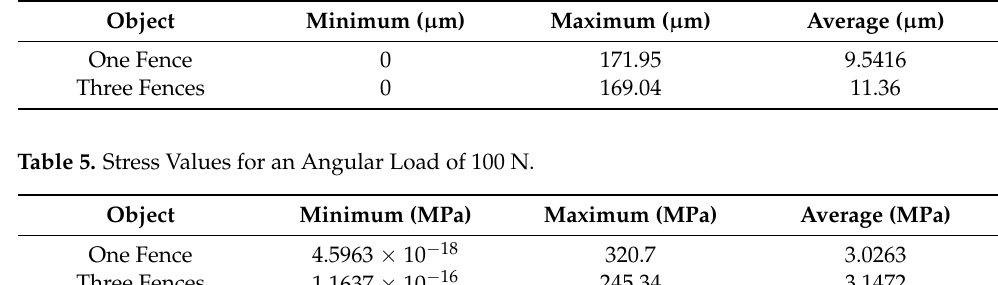
Table 4. Deformation Values for an Angular Load of 100 N.